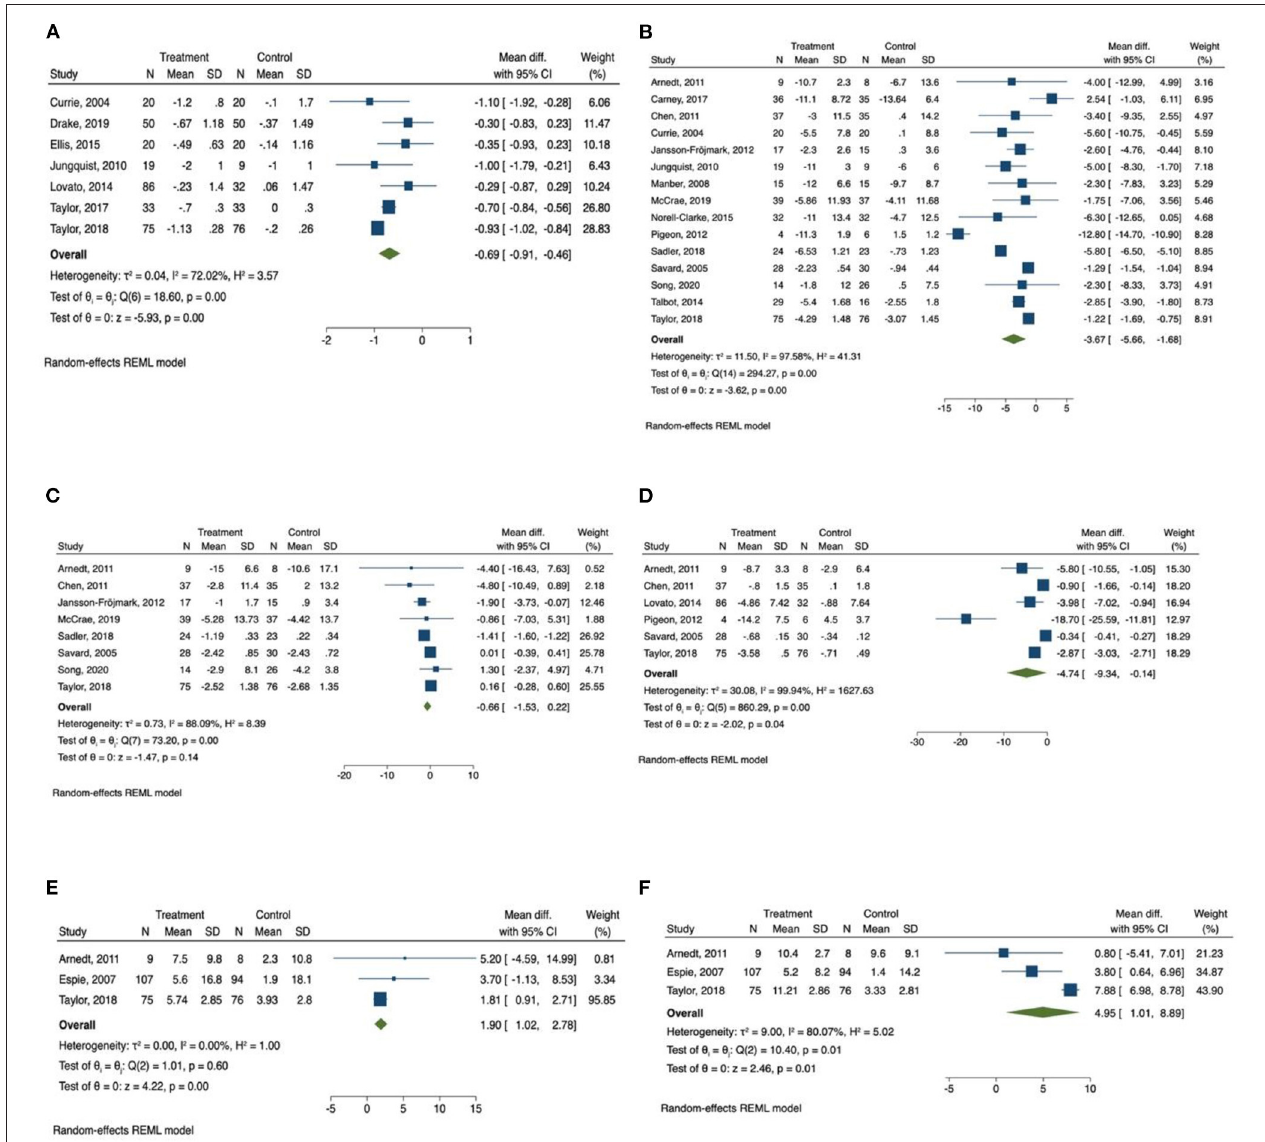
FIGURE 3 | Forest plots of the effect of CBT for sleep and health outcomes. (A) Number of awakenings, (B) depression, (C) anxiety, (D) Fatigue, (E) physical health, (F) mental health.